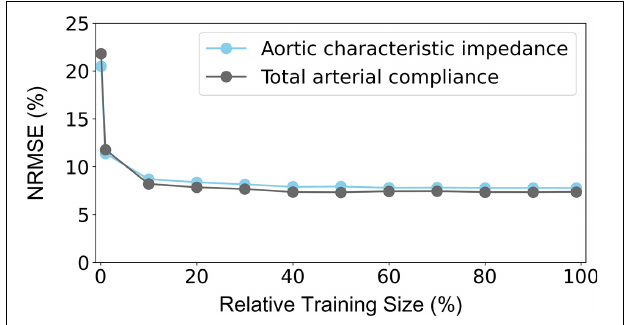
FIGURE 7 | Sensitivity of precision in terms of NRMSE to the number of the training data. The 100% of the training size corresponds to 2,290 cases. NRMSE: normalized root-mean square